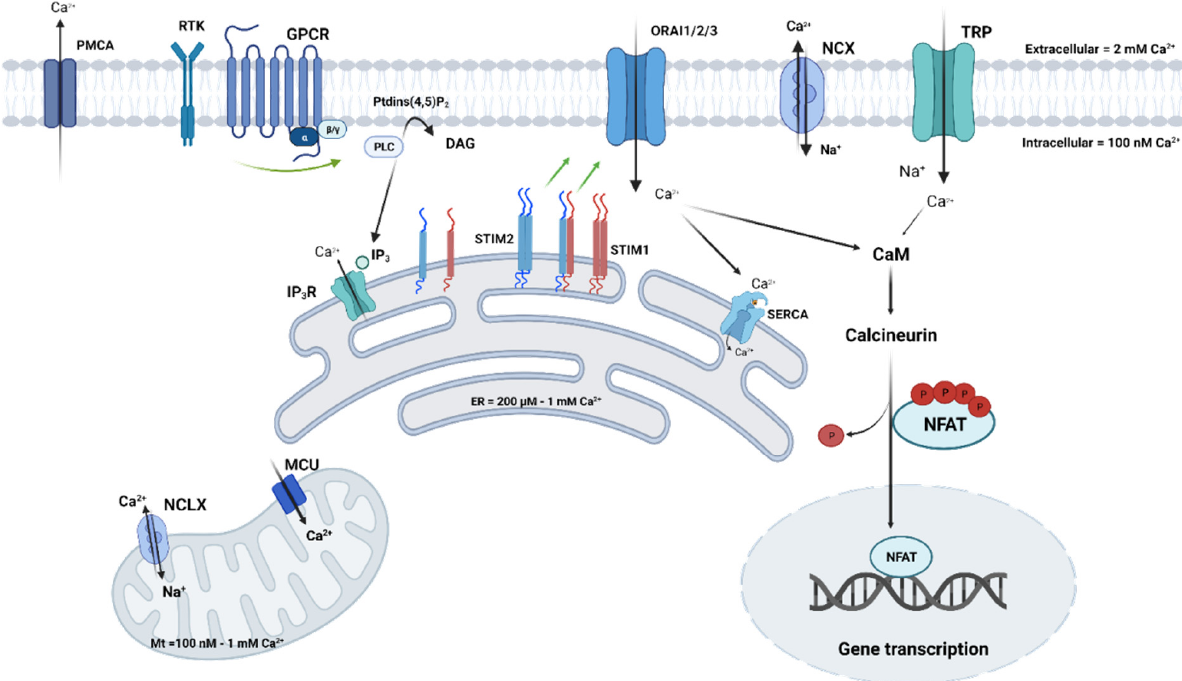
Figure 2. Ca 2+ homeostasis in non-excitable cells. Agonists bind to their receptors (GPCR or TK), which are located at the plasma membrane (PM), thereby activating PLC. The hydrolysis of phos- phatidylinositol 4,5-biphosphate leads to the production of IP 3 and the release of Ca 2+ from the ER store via IP 3 R. ER store depletion activates the STIM proteins, which translocate to ER–PM junctions and gate heterohexamer ORAI channels. Ca 2+ influx activates a set of proteins and effectors that are responsible for gene transcription. Calcium homeostasis is maintained by PM and organelle channels, transporters, and exchangers. Abbreviations: CaM: calmodulin; DAG: diacylglycerol; ER: endoplasmic reticulum; GPCR: G protein-coupled receptor; IP3R: inositol 1,4,5-trisphosphate receptor; Mt: mitochondria; MCU: mitochondrial Ca 2+ uniporter; NCX: Na + /Ca 2+ exchanger; NCLX: Na + /Ca 2+ /Li + exchanger; NFAT: nuclear factor of activated T-cells; PLC: phospholipase C; PMCA: plasma membrane Ca 2+ ATPase; PtdIns(4,5)P2: phosphatidylinositol 4,5-bisphosphate; RTK: receptor tyrosine kinase; SERCA: sarco-/endoplasmic reticulum Ca 2+ -ATPase; STIM: stromal interaction molecule. This figure was created using www.biorender.com.